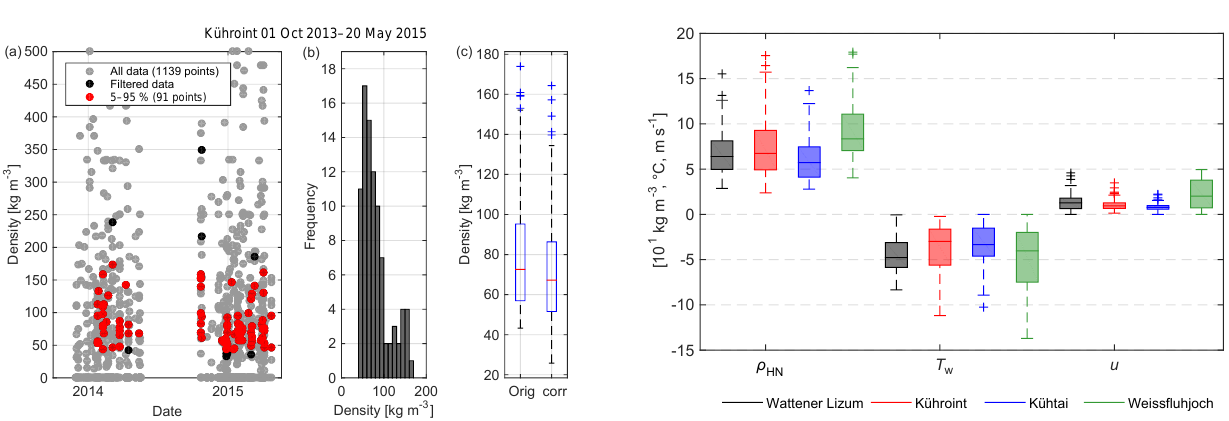
Figure 5. Box plot (median, 25 and 75% percentiles, 1.5 × interquartile ranges, outliers) of calculated new snow densities ( ρ HN ) based on observations, wet bulb temperature ( T w ) and wind speed ( u ) for filtered snowfall events (Table 2) at all four stations within period 1 (1 October 2013–20 May 2015).